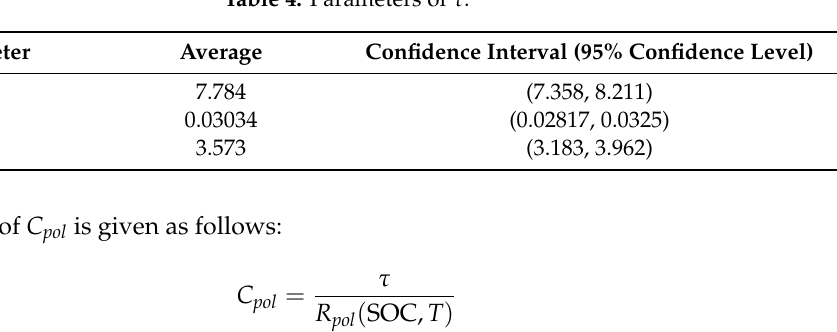
Table 4. Parameters of τ